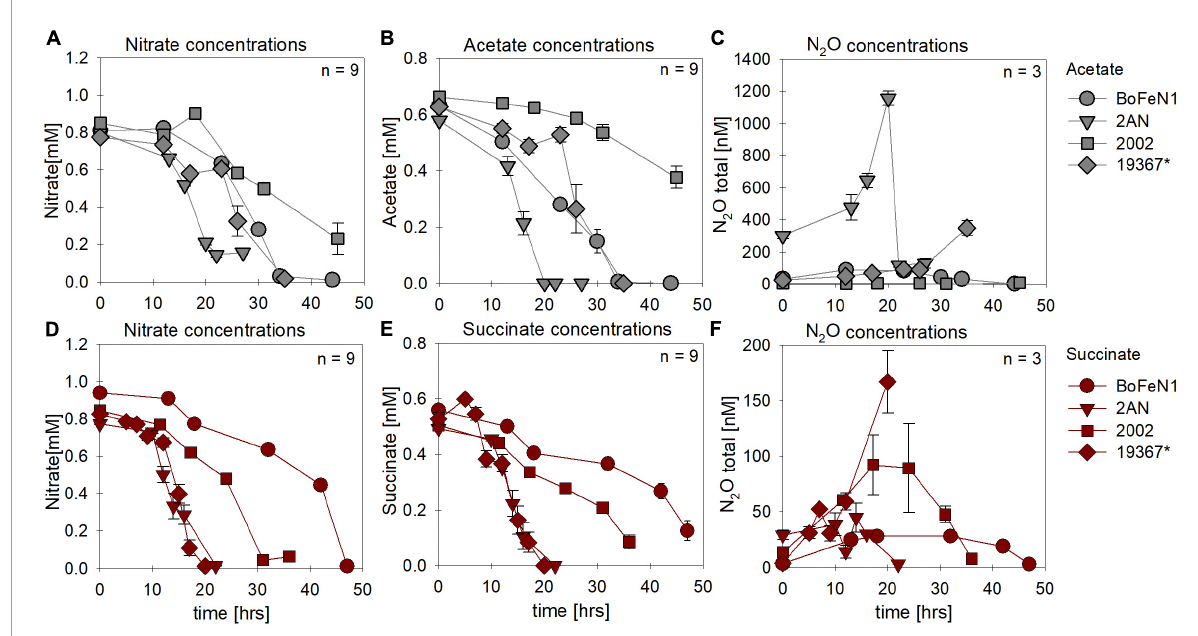
FIGURE1 Concentrations of nitrate (A,D) and organic acids [acetate (gray), succinate (red)] consumed (B,E) and N 2 O produced (C,F) during heterotrophic growth in strains of Acidovorax sp. strain BoFeN1, Acidovorax delafieldii strain 2AN, “ Pseudogulbenkiania ferrooxidans” strain 2002 and the control denitrifier (*) Paracoccus denitrificans ATCC 19367. Note that, for N 2 O concentrations, different axis scales are applied. Standard error calculated from biological replicates ( n = 9, 3) is represented by the error